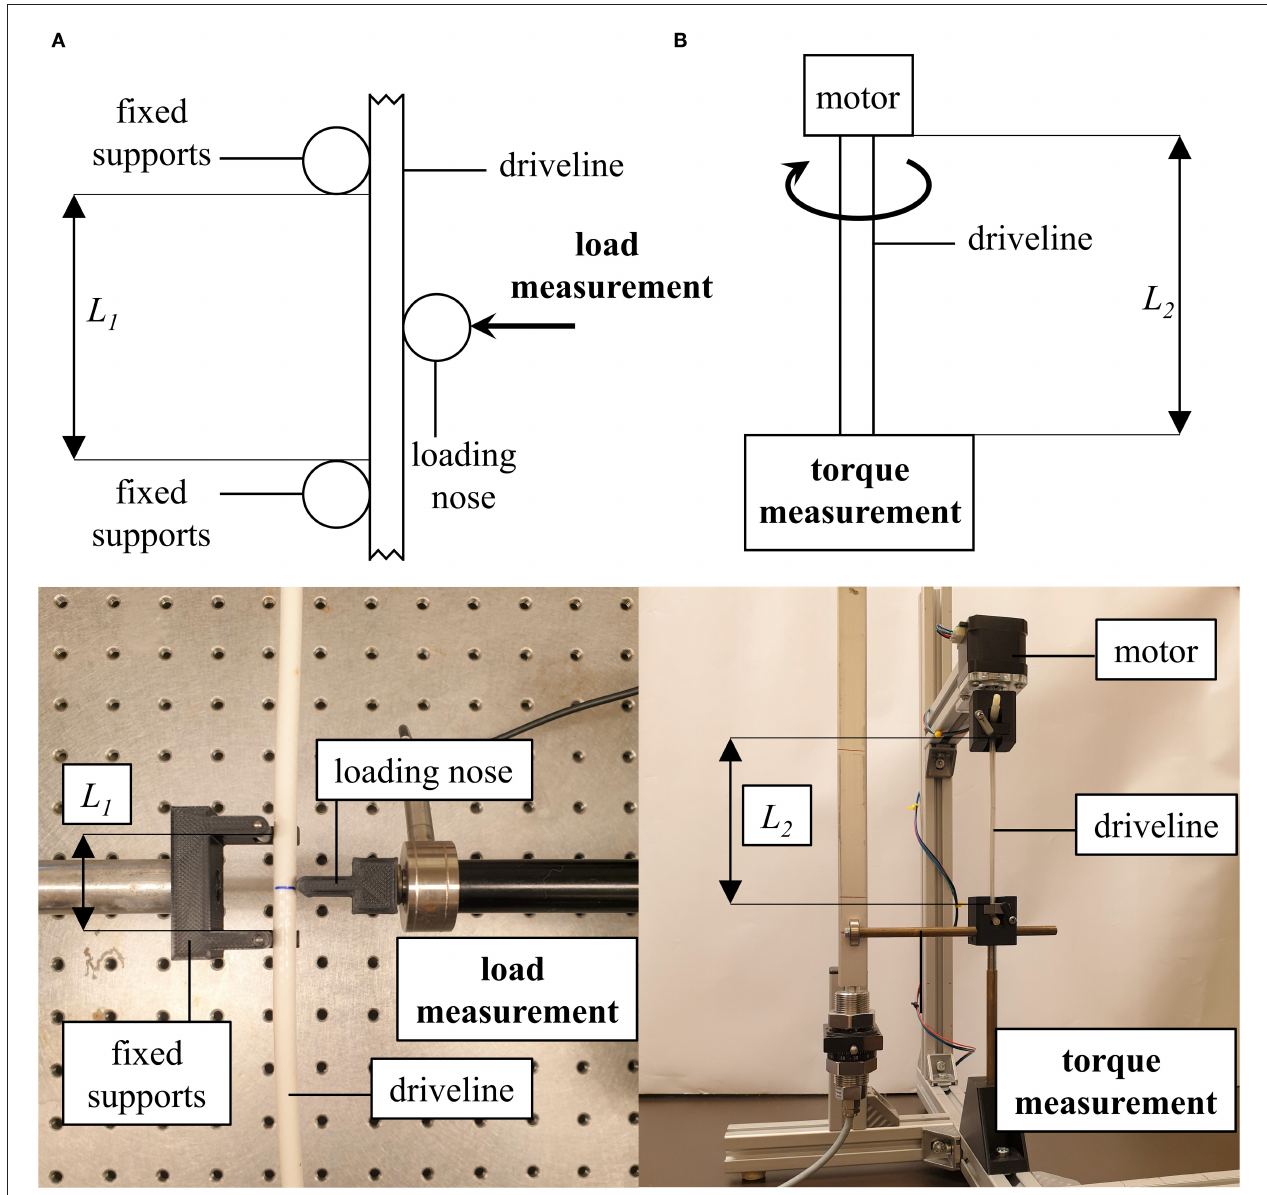
FIGURE 2 | Measurement setup of the three-point bending (A) and torsion test (B) . (L 1 ) support span, (L 2 ) free length.